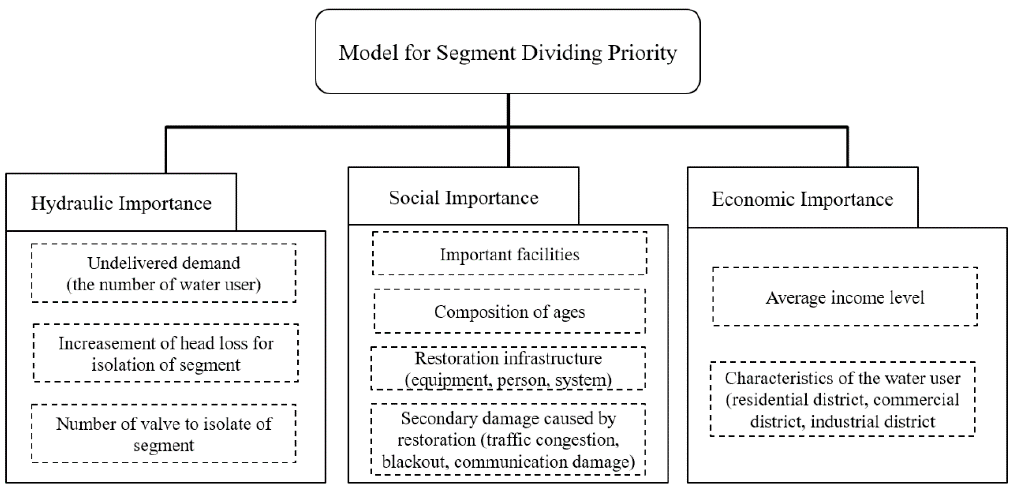
Figure 1. Model for segment division priority.